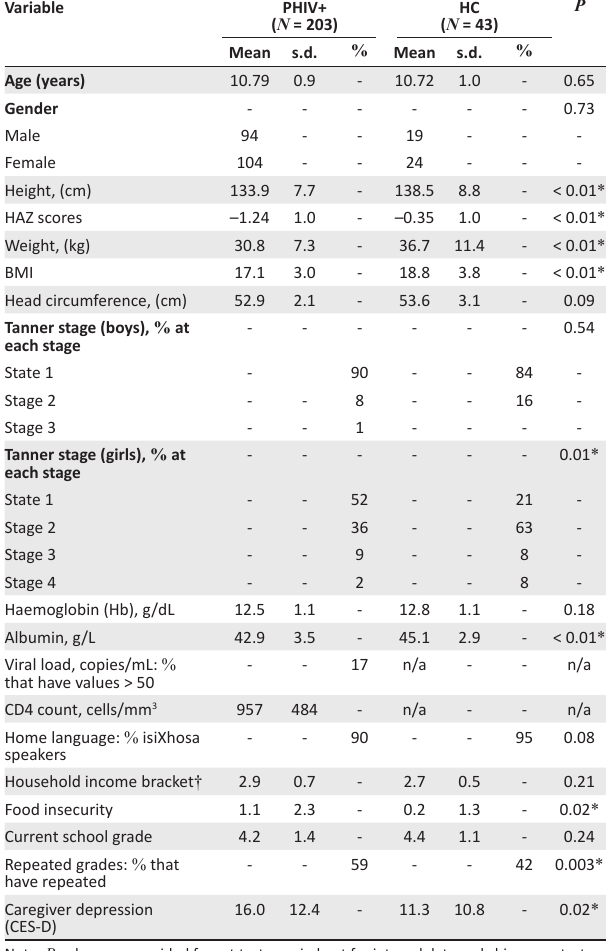
TABLE 1: Baseline demographic and clinical characteristics of the cohort, comparing perinatally acquired HIV infection and healthy controls groups.